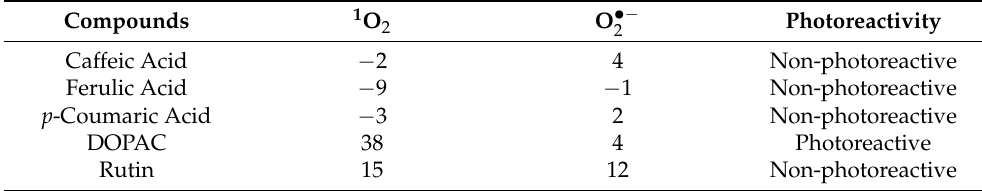
Table 2. Results obtained for the tested compounds using the ROS